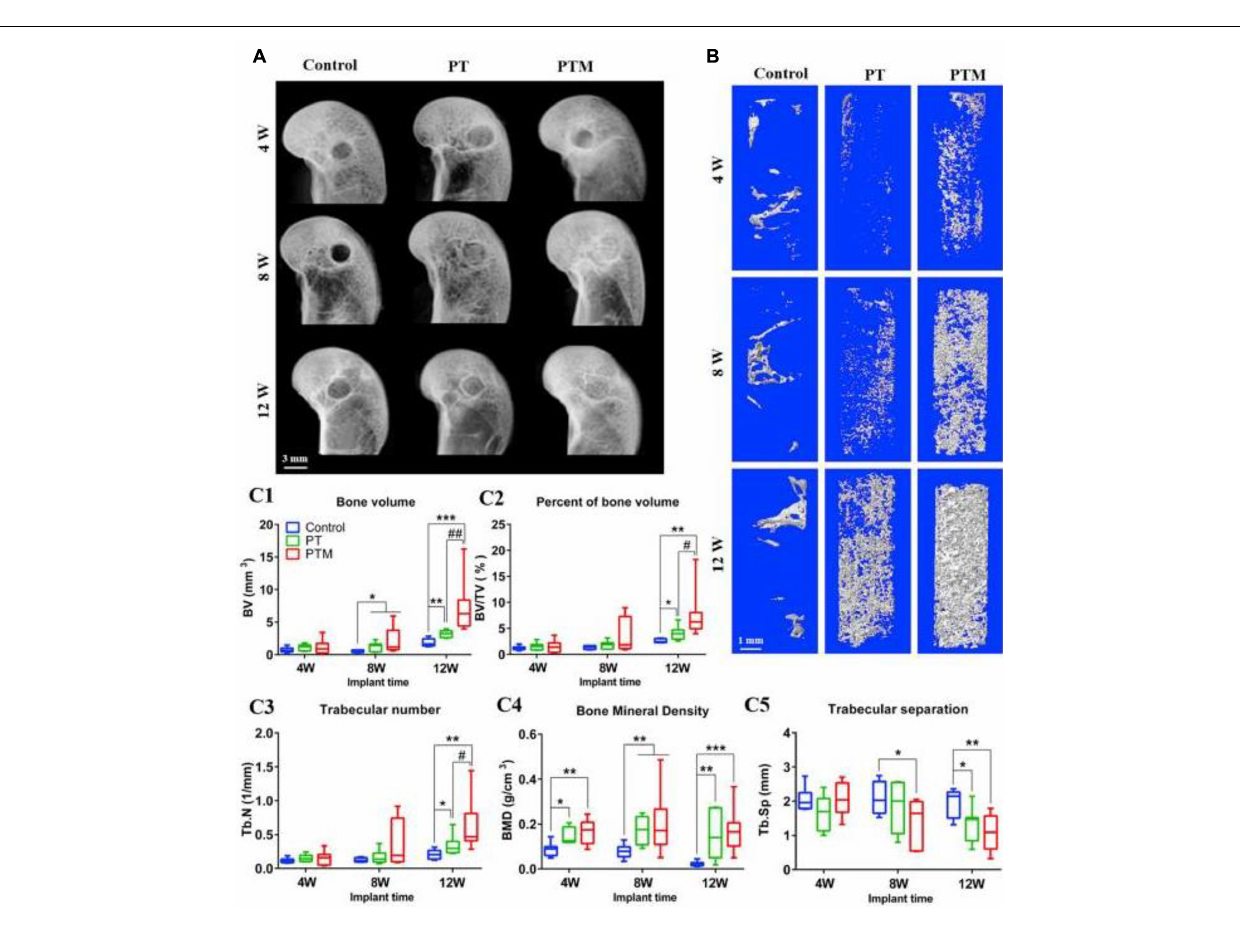
FIGURE 3 | New bone formation within bone tunnel. (A) Representative radiographs at 4, 8, and 12 weeks after surgery. (B) Representative 3D micro-CT images within a region of interest of central 2.5 mm in diameter of the bone tunnel at 4, 8, and 12 weeks after surgery. (C) Quantitative analysis of micro-CT of the new bone in the bone tunnel at 4, 8, and 12 weeks after surgery: (C1) BV; (C2) BV/TV; (C3) Tb.N; (C4) BMD; (C5) Tb. Sp. n = 8. * p < 0.05 vs. control group, ** p < 0.01 vs. control group, *** p < 0.001 vs. control group, # p < 0.05 vs. PT group, ## p < 0.01 vs. PT group. Reproduced from Lai et al. (2019) with permission from Elsevier (Copyright